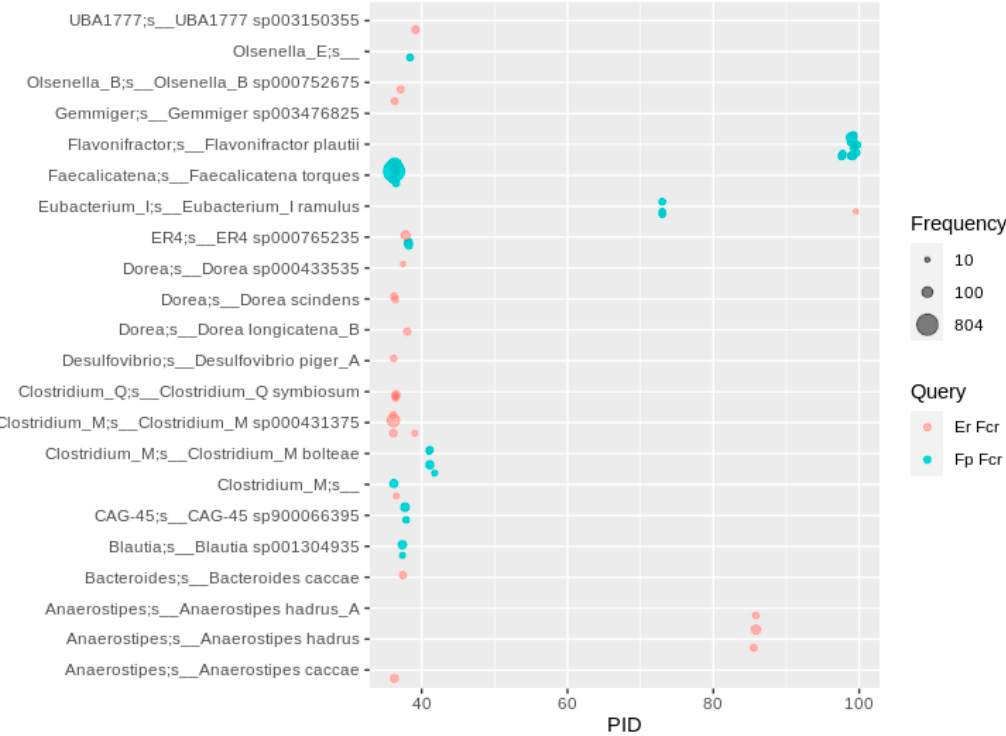
Figure 8. Fcr-like enzymes in human gut MAGs. Hits were filtered for at least 10 occurrences, so that each bubble represents a number of redundant sequences ranging from 10 to 804.